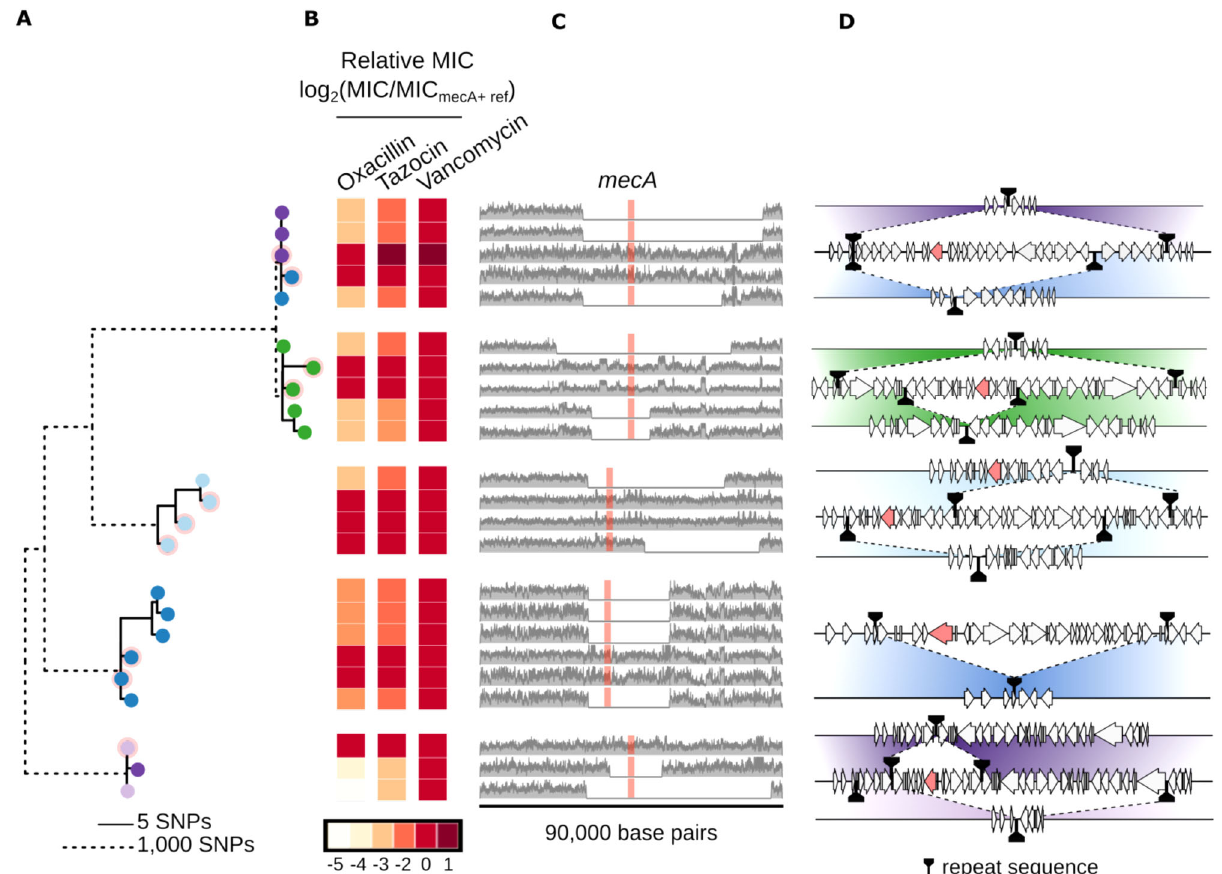
Fig. 4 Structural variation in the SCC mec island evolved independently in fi ve different S. epidermidis strains through site-speci fi c recombination at canonical and non-canonical sites, all leading to functional differences in resistance to β -lactam antibiotics. A Maximum-likelihood phylogeny based on single-nucleotide polymorphisms (SNPs) with isolate representatives from strain backgrounds with structural variation in the region containing mecA . To depict SNP-level variation within strains (solid line branches), the scale for within-strain branches has been stretched by 200× compared to between-strain branches (dotted line branches). Pink backgrounds denote isolates whose genomes contain mecA . B MIC of each isolate relative to its closest mecA - containing relative for two β -lactam antibiotics (oxacillin and Tazocin) and one non- β -lactam antibiotic (vancomycin). C Read coverage across a 90,000- base pair region containing mecA (red box). Note that the region of interest is different for each strain background. D Putative recombination events leading to structural changes in the SCC mec island ( mecA ORF in red; all other ORFs are gray; repeat sequence based recombination sites in black). Source data are provided as a Source Data fi